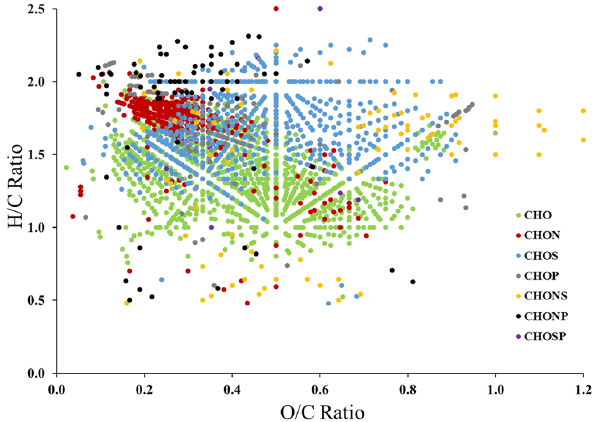
Figure 4. van Krevelen diagram for the 2408 aerosol WSOM molecular formula input variables to the Principal Component Analysis. Data points are color coded for molecular formula ele- mental composition as described in the figure key.